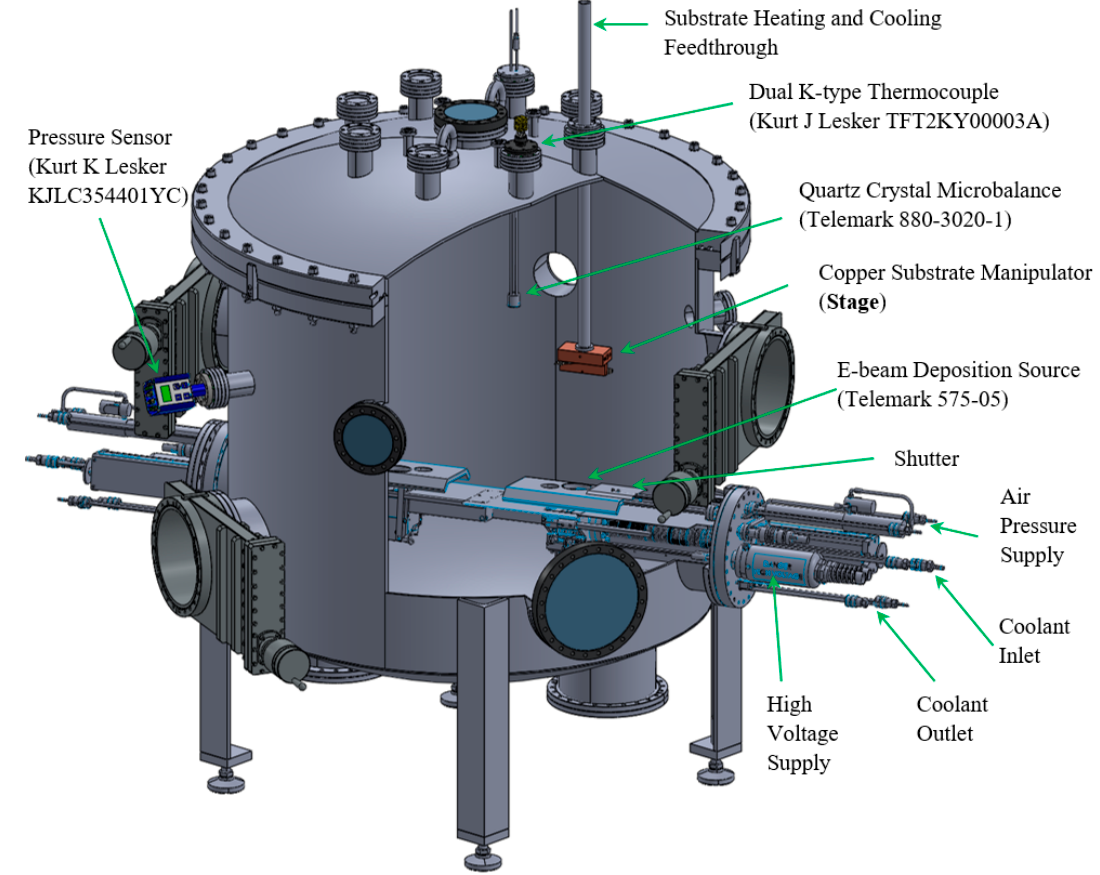
Figure 1. Schematic of the deposition chamber highlighting various